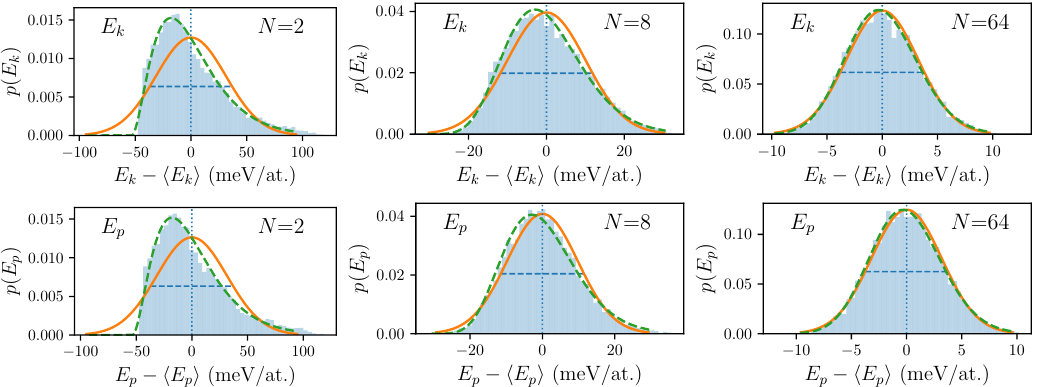
Figure 2: Probability distribution for single atom kinetic (upper) and potential (lower) energies averaged over N = 2, 8 and 64 randomly selected atoms. Solid orange lines show fitted normal distributions while dashed green lines show χ 2 dis- tribution for 3 N degrees of freedom fitted to energy histograms. Data derived from the MD trajectory run at 300 K